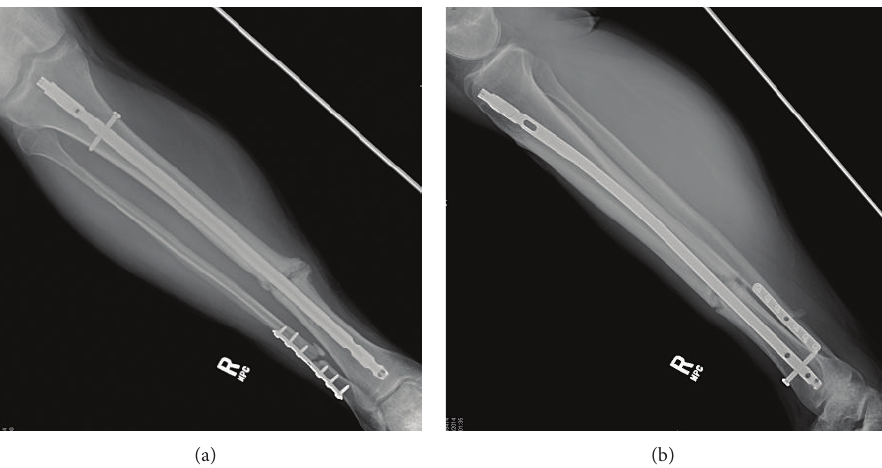
Figure 1: ((a) and (b)) Radiographs of a hypertrophic tibial nonunion in a 35-year-old man ten months status after medullary fixation of an open tibial shaft fracture with persistent pain and inability to weight bare. Note abundant callus formation but persistent fracture line.